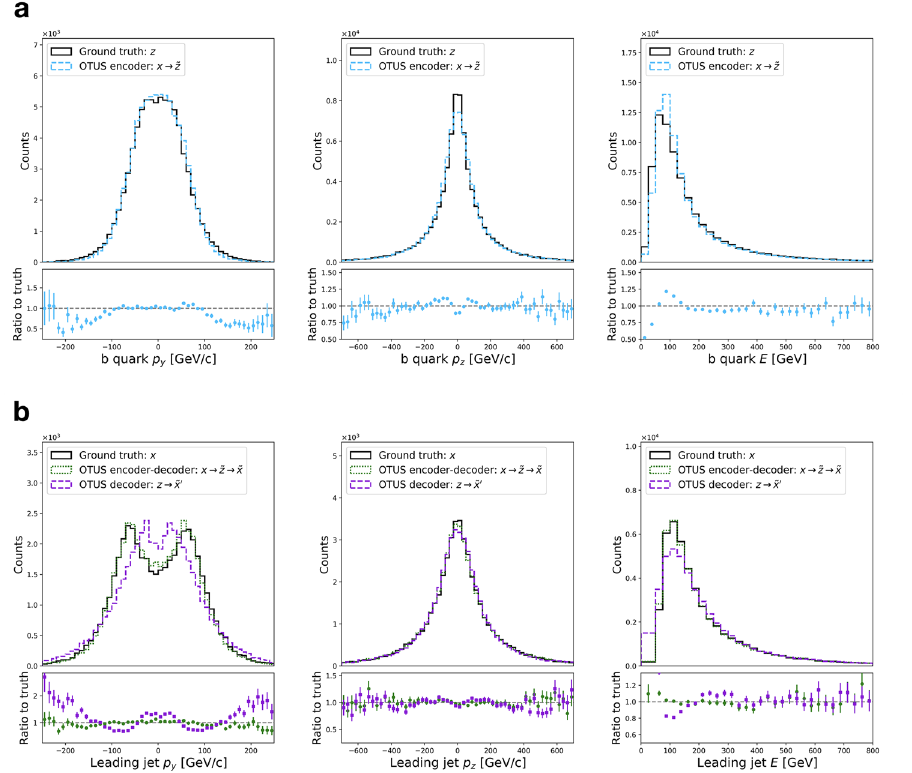
Figure 6. Performance of OTUS for semileptonic t ¯ t decays. ( a ) Matching of the b quark’s p x , p y , and E distributions in Z . It shows distributions of samples from the theoretical prior, { z ∼ p ( z ) } (solid black), as well as the output of the encoder, { ˜ z } ; the encoder transforms samples of the testing data in experimental space, X , to the latent space, Z , and is shown as x → ˜ z (dashed cyan). ( b ) Matching of the leading jet’s p x , p y , and E distributions in X . It shows the testing sample { x ∼ p ( x ) } (solid black) in the experimental space, X , as well as output from the decoder applied to samples drawn from the prior p ( z ), labeled as z → ˜ x ′ (dashed purple). Also shown are samples passed through both the decoder and encoder chain, x → ˜ z → ˜ x (dotted green). Dotted green and solid black distributions are matched explicitly during training. Enhanced differences between dashed purple and solid black indicate the encoder’s output needs improvement, as p E ( z ) does not fully match p ( z ). If performance were ideal, the distributions in every plot would match up to statistical fluctuations. Residual plots show bin-by-bin ratios with statistical uncertainties propagated accordingly (see